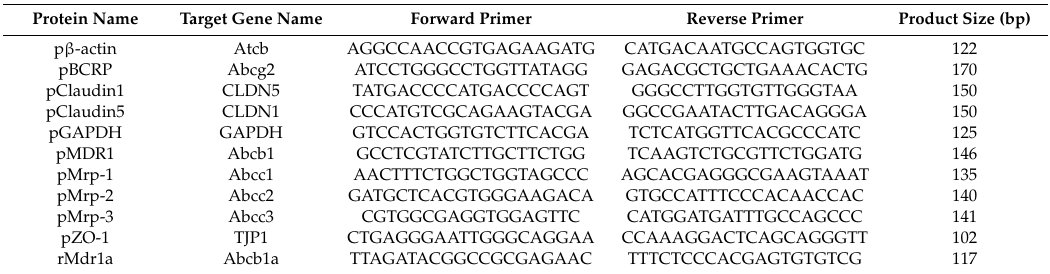
Table 1. Sequence of primers used for quantitative polymerase chain reaction